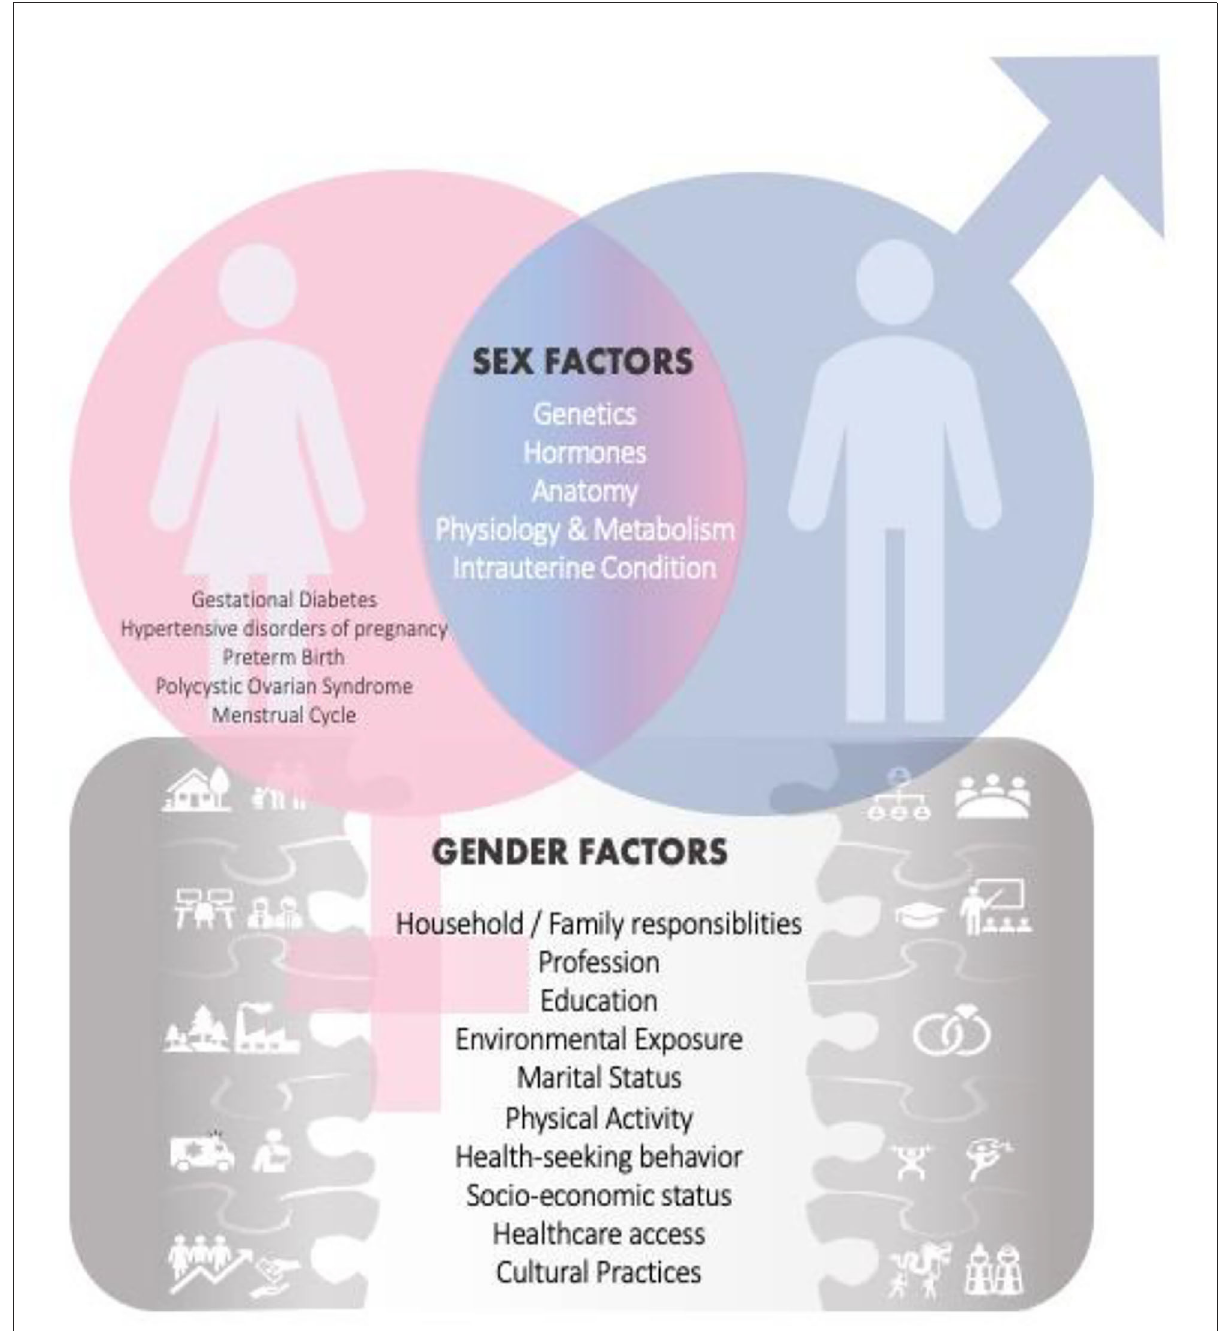
FIGURE1 Sex and Gender Factors influence research and health outcomes. In addition to the usual shared sex factors among males and females, there are also sex related factors [i.e., gestational diabetes, hypertensive disorders of pregnancy, polycystic ovarian syndrome (PCOS), menstrual cycle ] specific only to women. This female-specific factor places a heavier burden on certain diseases in women. Gender factors are also introduced, and those may have an effect on health and disease outcomes.